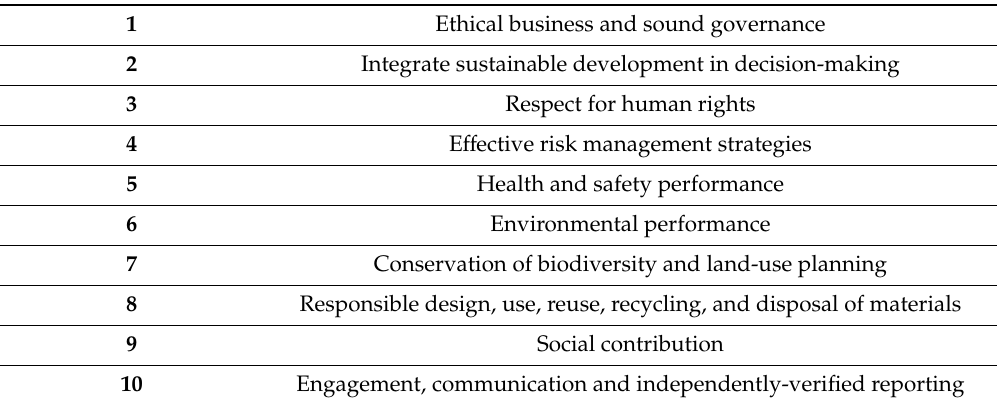
Table 1. Sustainable development principles of